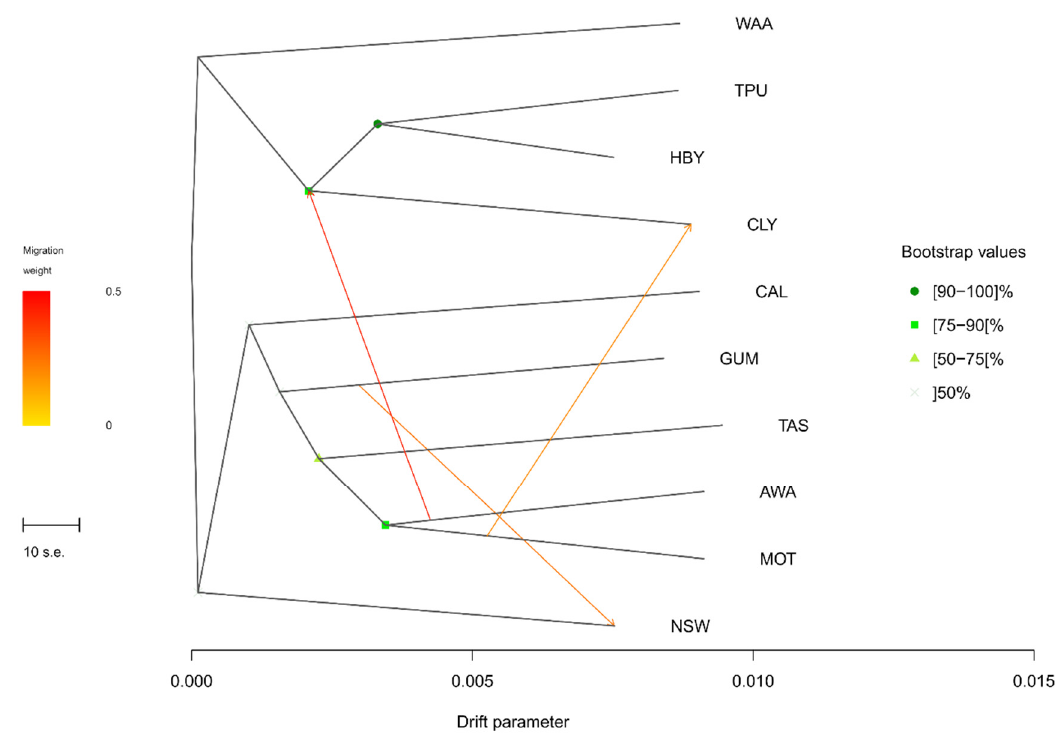
Figure 4. Historical relationships and inferred migration events (indicated by the coloured arrows) among Epiphyas postvittana populations obtained with TreeMix.